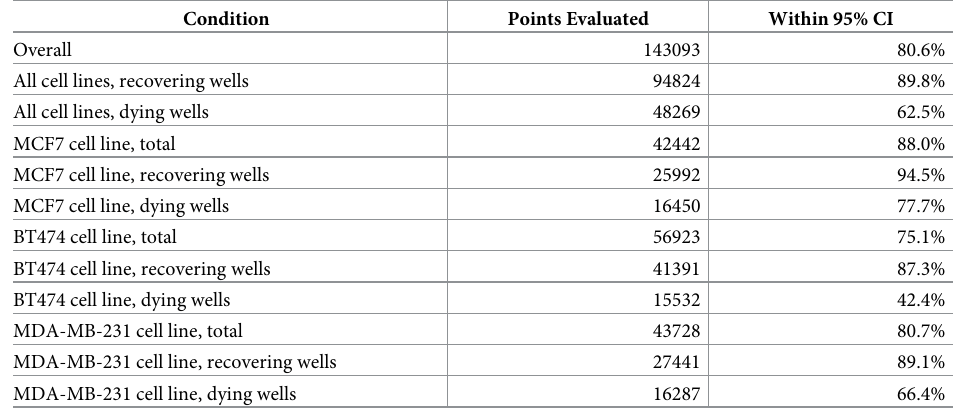
Table 3. Leave-one-out cross validation. The performance of model 1 at predicting data excluded from the training set is broken down by cell line and whether the replicate culture recovered or not (see Fig 4).